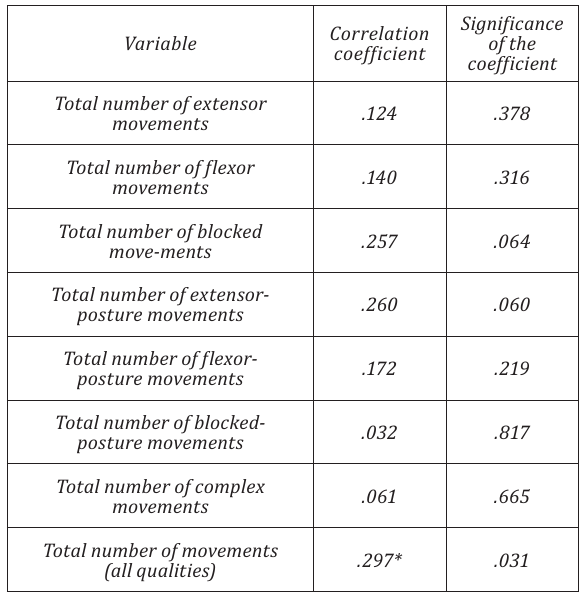
Table 9. The values of Spearman’s rho between the shading variable and movement quality variables in the total